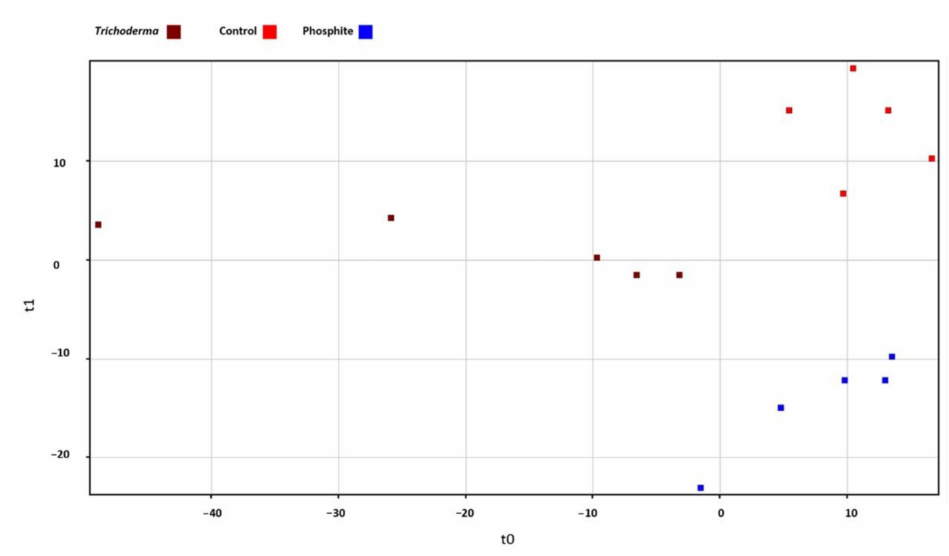
Figure 2. Partial least squares discriminant analysis (PLS-DA) on plants according to their metabolic response to Trichoderma and phosphite. Individual replications are given in the class prediction model score